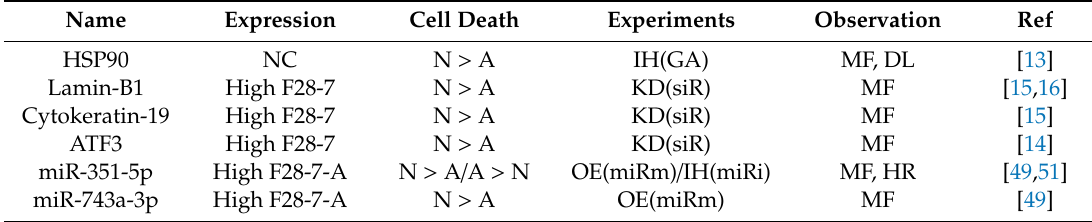
Table 2. Identification of switch regulators, necrosis, and